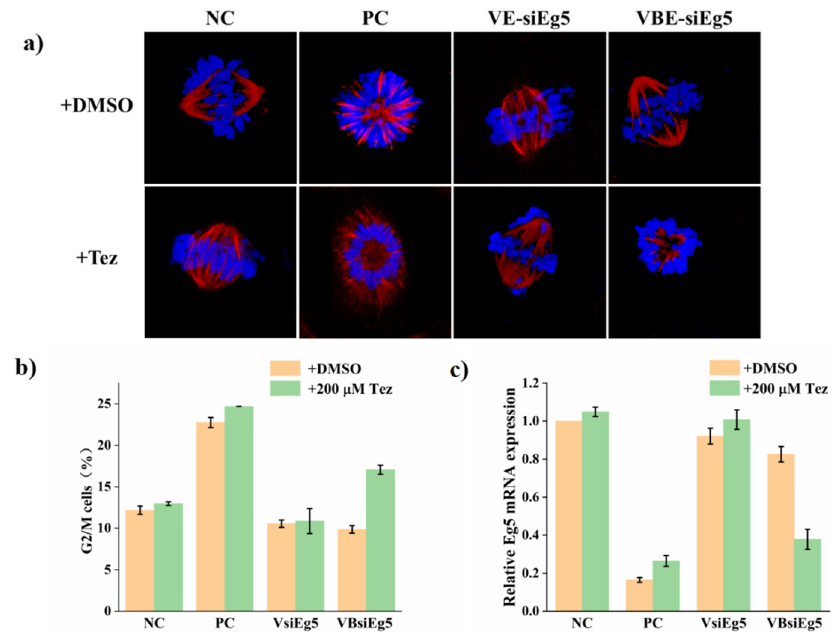
Figure 3. Activation of VBsiRNA for Eg5 gene silencing with tetrazine (200 µ M). ( a ) Confocal imaging of cells stained with Hoechst 33,342 and Tubulin-Tracker Red. ( b ) Cell cycle analysis of the cells stained with propidium iodide using flow cytometry. ( c ) The Eg5 mRNA expression quantified by real time-qPCR. The concentration of siRNAs was 1.5 nM. For flow cytometry data in ( b ) and real time-qPCR data in ( c ), at least three independent experiments were performed. Error bars represent standard deviations.